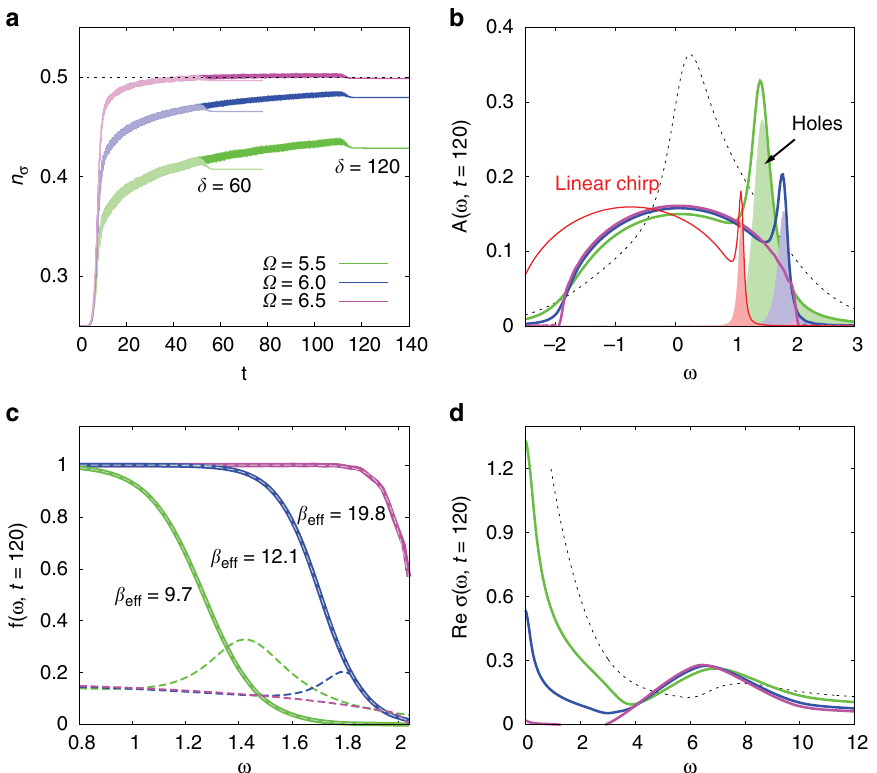
¼ 0 : 8 and max ¼ 0 : 8. (The red max ¼ 6 : 6 and Ω ¼ 7 : 4). in fin